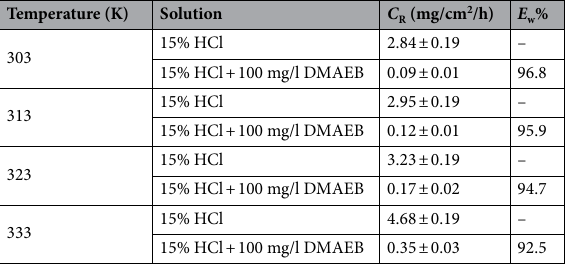
Table 4. Corrosion parameters obtained from mass loss method for N80 C-steel pipe in 15% HCl solution without and with 100 mg/l DMAEB at different temperatures.